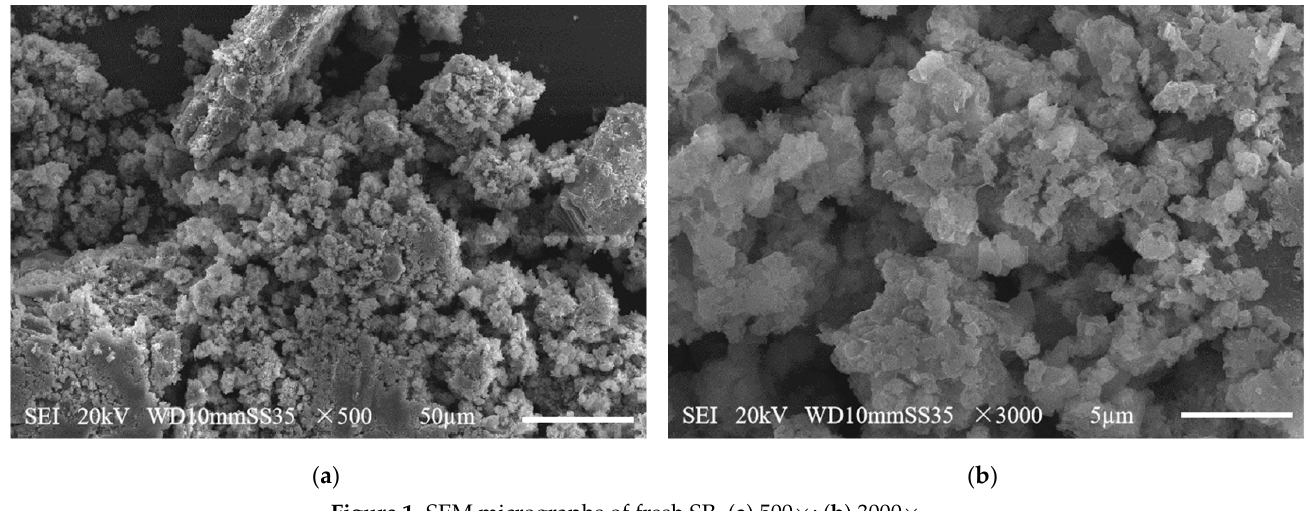
Figure 1. SEM micrographs of fresh SR. ( a ) 500×; ( b ) 3000×.